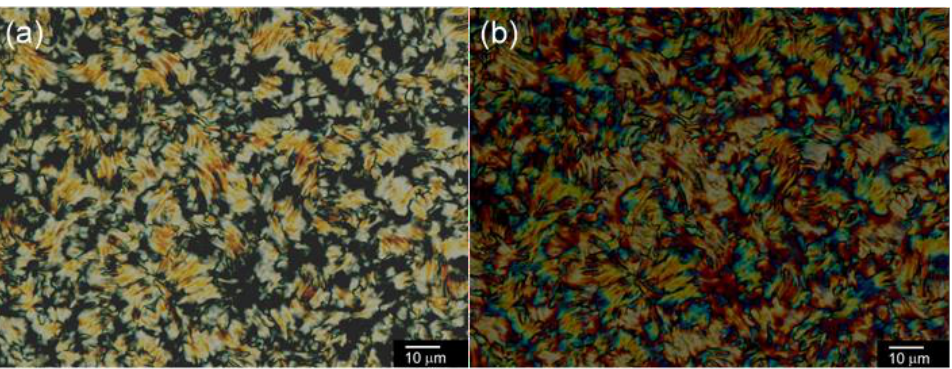
Figure 6. ( a ) POM images of the SmC*–LC–poly(Ar–Pyr) blend with the chiral inducer, C6BPC8*. ( b ) Circular polarized differential interference contrast optical microscopy (C-DIM) image of the SmC*–LC–poly(Ar–Pyr) blend with C6BPC8*, the same region as (a). The chiral molecule of the three-ring system with an optically active, terminal alkyl group (0.25